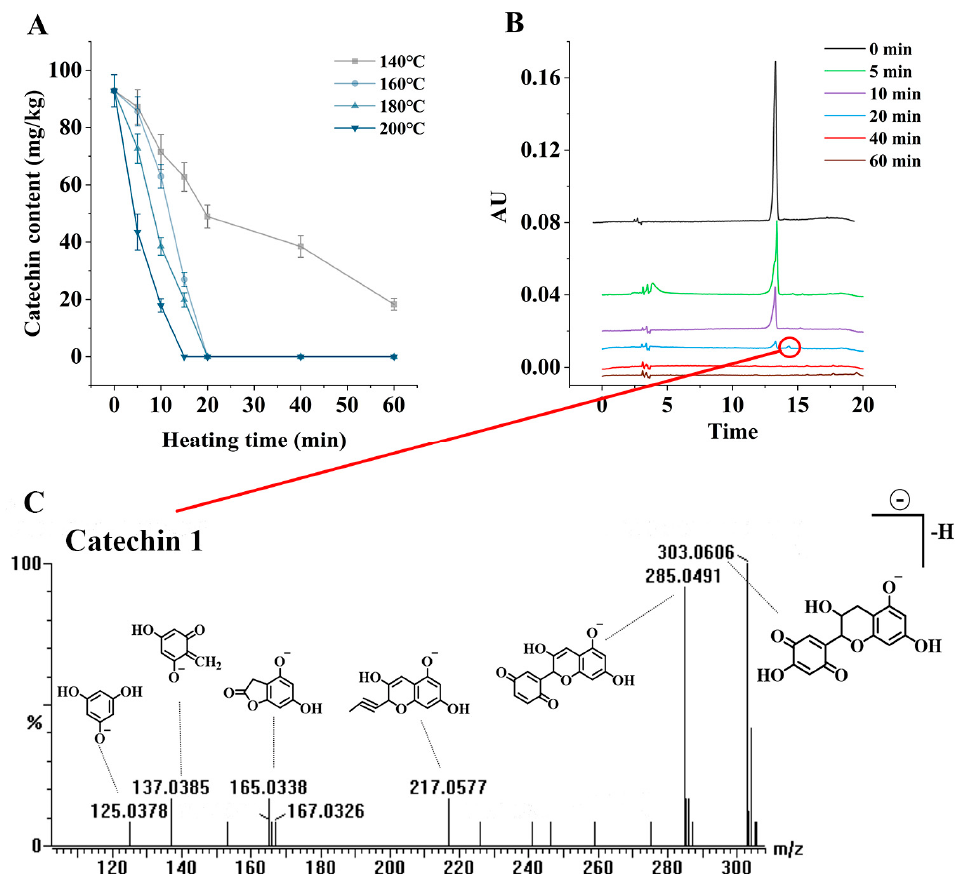
Figure 6. Contents of catechin at different temperatures with heating time ( A ); Chromatograms of catechin and catechin 1 at 160 °C for different heating times ( B ); Mass spectrum of catechin 1 and speculated fragment structure ( C ).